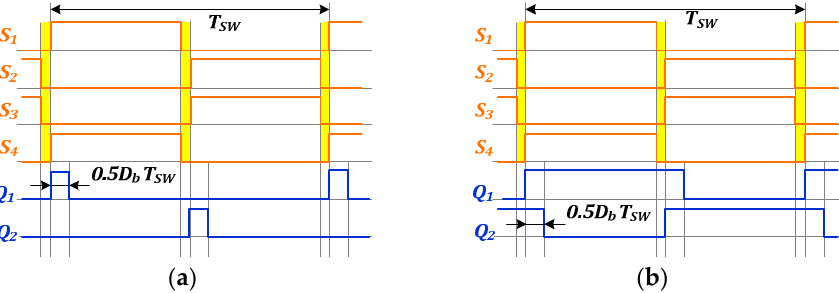
Figure 2. Possible PWM schemes for the bidirectional switch: ( a ) simple boost PWM and ( b ) phase-shifted PWM with overlapping signals.